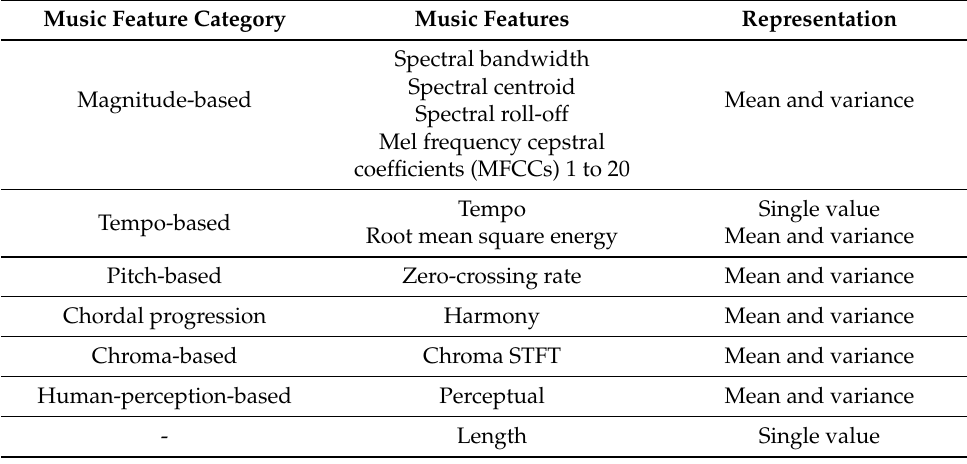
Figure 2. Data distribution of the GTZAN dataset. Table 2. Music features in the GTZAN